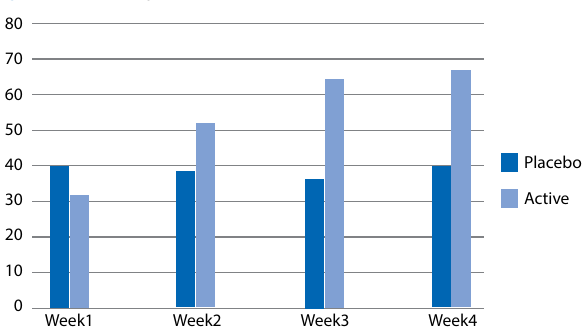
Figure 1: Percentage Patients Who Experienced Adequate Relief